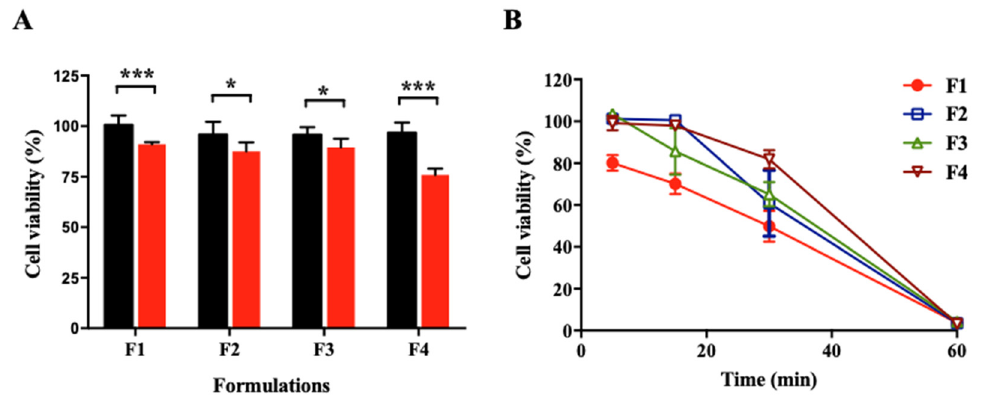
Figure 5. Cytotoxicity of formulations and formulations without USL in conjunctival epithelial cells for 6 h ( n = 3). ( A ) Protective e ff ect of formulations from dehydration according to time. Cells were pre-incubated with the formulations for 30 min and placed under dehydrating conditions ( n = 3). ( B ) Black or red bars represent the formulation with or without USL, respectively. * p < 0.05, significantly di ff erent from the formulation with USL. *** p < 0.001, significantly di ff erent from the formulation with